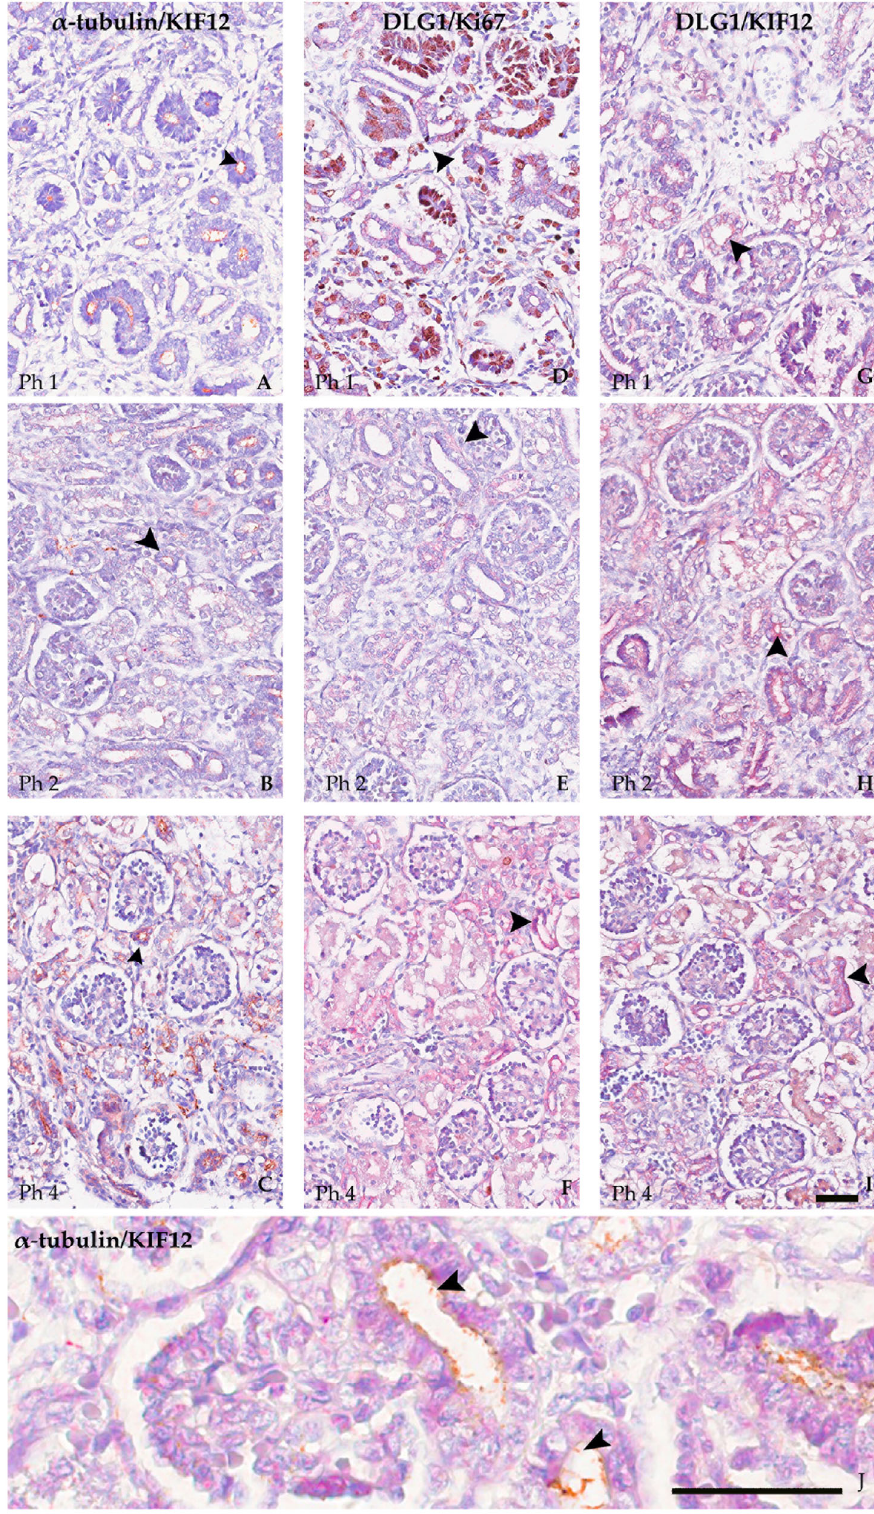
Figure 10. Co-localization (arrow) of KIF12 and α -tubulin, DLG1 with Ki-67 and DLG1 with KIF12 in Figure 10. Co ‐ localization (arrow) of KIF12 and α‐ tubulin, DLG1 with Ki ‐ 67 and DLG1 with KIF12 Ph1, Ph2, and Ph4 (double immunohistochemistry, ( A – I ) magnification 20 × , ( J ) magnification 80 × , in Ph1, Ph2, and Ph4 (double immunohistochemistry, ( A – I ) magnification 20×, ( J ) magnification 80×, first marker red, second marker brown). Scale bar is 40 µ m. For negative control, see Supplementary first marker red, second marker brown). Scale bar is 40 μ m. For negative control, see Supplementary Figure S2. Figure